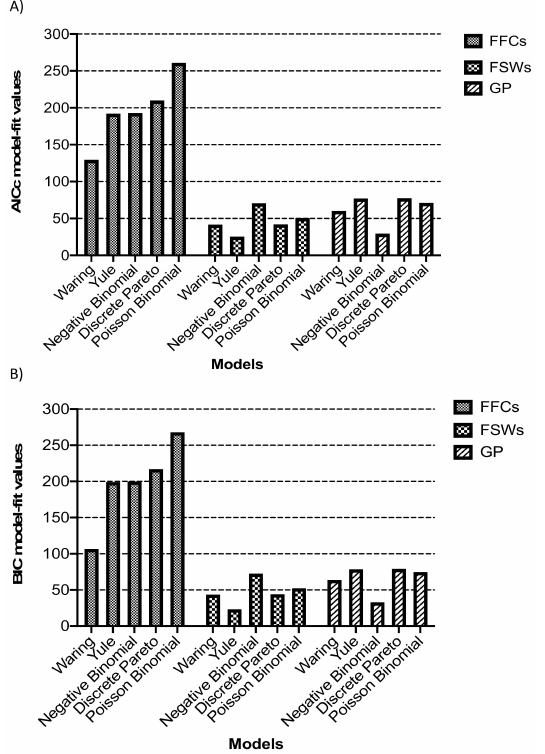
Figure 3. Model fit statistics. Five models that included the discrete Pareto, Yule, Waring, Negative Binomial and Poisson lognormal were fitted to the observed network degree distributions inferred from HIV sequence datasets of fisherfolk communities (FFCs), female sex workers (FSWs) and the general population (GP). ( A ) shows the corrected Akaike Information Criteria scores for the model fit while ( B ) shows the Bayesian Information Criteria (BIC) scores. The model with the lowest AICc and BIC scores was considered as the best-fitting